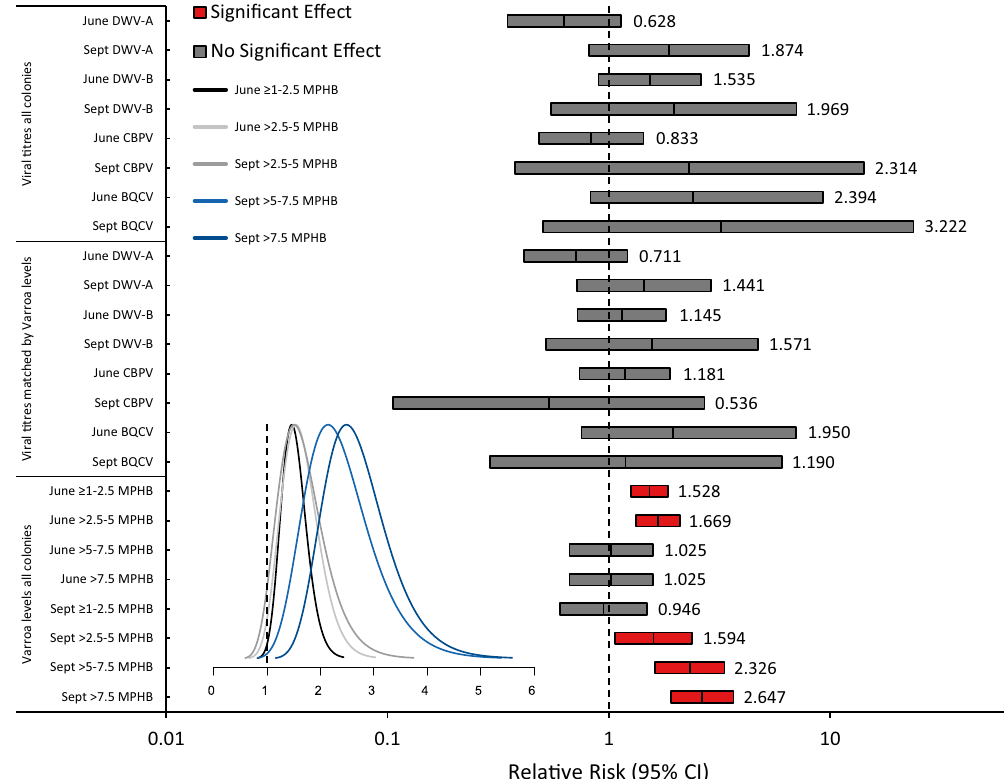
Figure 5. Relative mortality risks of Varroa levels ( N Commercial = 193, N Pol-line = 173), viral titres ( N Commercial = 46, N Pol-line = 42), and viral titres controlled for Varroa levels ( N Commercial = 30, N Pol-line = 30), as epidemiological exposure factors. Bars display relative risk point estimates, bounded by 95% confidence intervals, displayed on a log 10 scale to accurately represent proportional change in risk. Colours indicate factor significance (RR, point estimate ± CI 95% > 1.00, P < 0.05) as a predictor of mortality (significant effect, red; no significant effect, dark grey). Numbers provide exact relative risk point estimates. The inset displays posterior risk probability densities for significant factors, encompassing 100% credible intervals. Colours indicate factor (June ≥ 1–2.5 MPHB, black; June > 2.5–5 MPHB, light grey; September > 2.5–5 MPHB, dark grey; September > 5–7.5 MPHB, light blue; September > 7.5 MPHB, dark blue). For full details of exposure groupings, see “Materials and